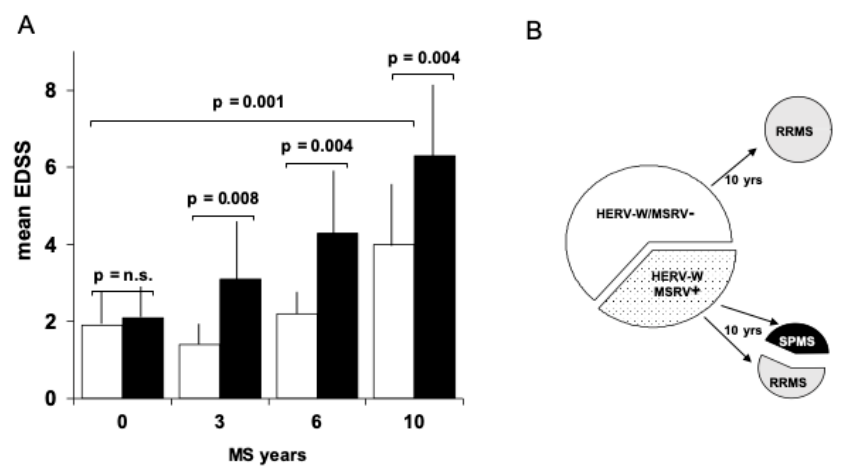
Figure 2. Clinical evolution along ten years of 22 multiple sclerosis (MS) patients differing at onset only for presence/absence of HERV-W/MSRV in the cerebrospinal fluid (CSF). ( A ) Mean expanded disability status scale (EDSS). Over the 10 years, the patients with HERV-W/MSRV(+) CSF at the onset (black bars) progressed with significantly higher disability, with respect to the patients with HERV-W/MSRV(-) CSF (white bars). ( B ) MS forms of the cohort at entry and after 10 years of follow-up. Forty-three % of the patients with HERV-W/MSRV(+) CSF converted into secondary-progressive MS (SPMS), while those with HERV-W/MSRV(-) CSF at onset remained in relapsing-remitting MS (RRMS) [29–31].